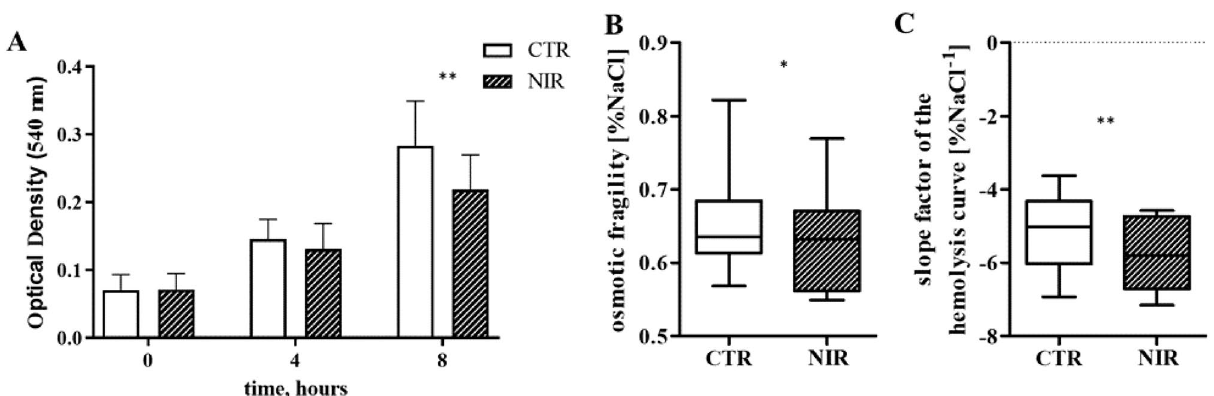
Figure 7. Changes in OD at 540 nm (ordinate) represent the results obtained from the plasma-free hemoglobin spectrophotometric assay that indicated erythrocyte breakdown with time of blood incubation in the experimental system (MANOVA test results for interaction, time, and group were p < 0.001, p < 0.001, p < 0.05, respectively) ( A ). The results are presented as mean values ± standard deviation. **p < 0.01 for CTR (empty bar) vs NIR 1.5 mW/cm 2 (diagonal pattern) at a given time point. Furthermore, significant changes (***p < 0.001) were also found compared to other time points within each group, and different time points for intergroup comparison. The number of measurements n = 20. Differences in the parameters of the hemolysis curve at t (4 h): osmotic fragility ( B ) and the slope of the hemolysis curve ( C ) (Wilcoxon’s test in both cases). The results are presented as the median value and the interquartile range. The number of measurements n =